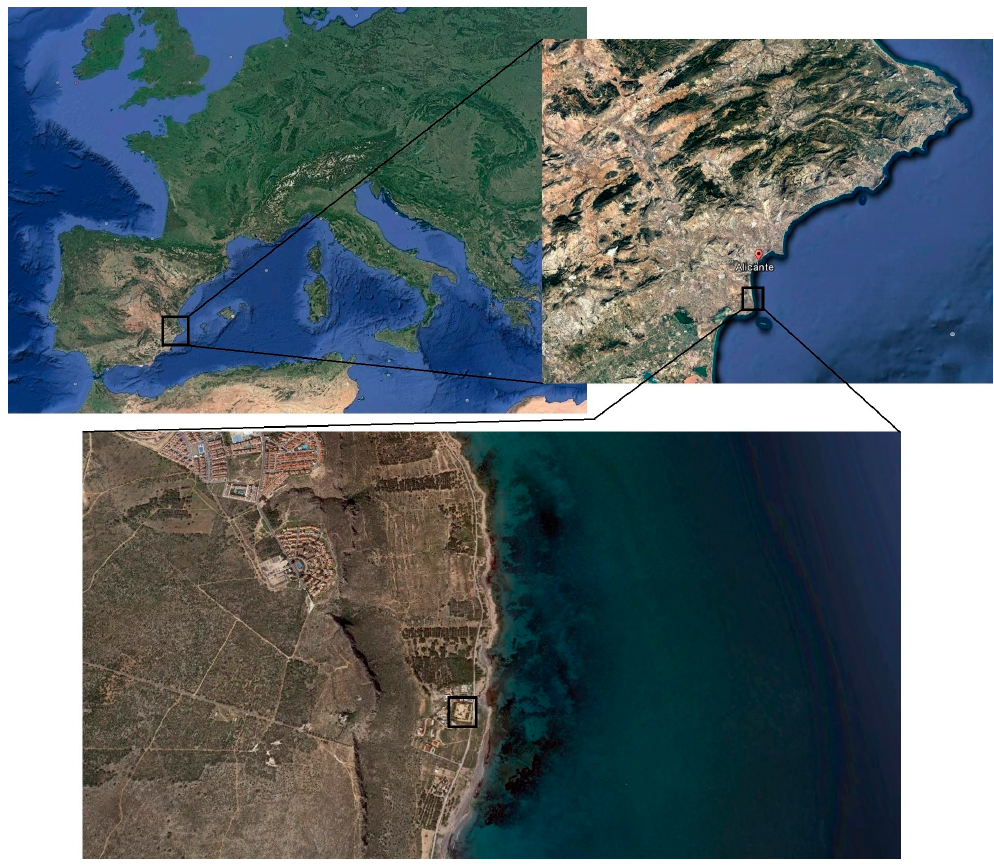
Figure 1. Location of the real exposure site (black line squares) for environment C. The samples were placed in an exposure station located in the Santa Pola’s Cape (Alicante province, Spain). The distance from this exposure site to the Mediterranean Sea was about 100 m. The satellite images were obtained using the Google Earth software (Google, Santa Clara, CA, USA).